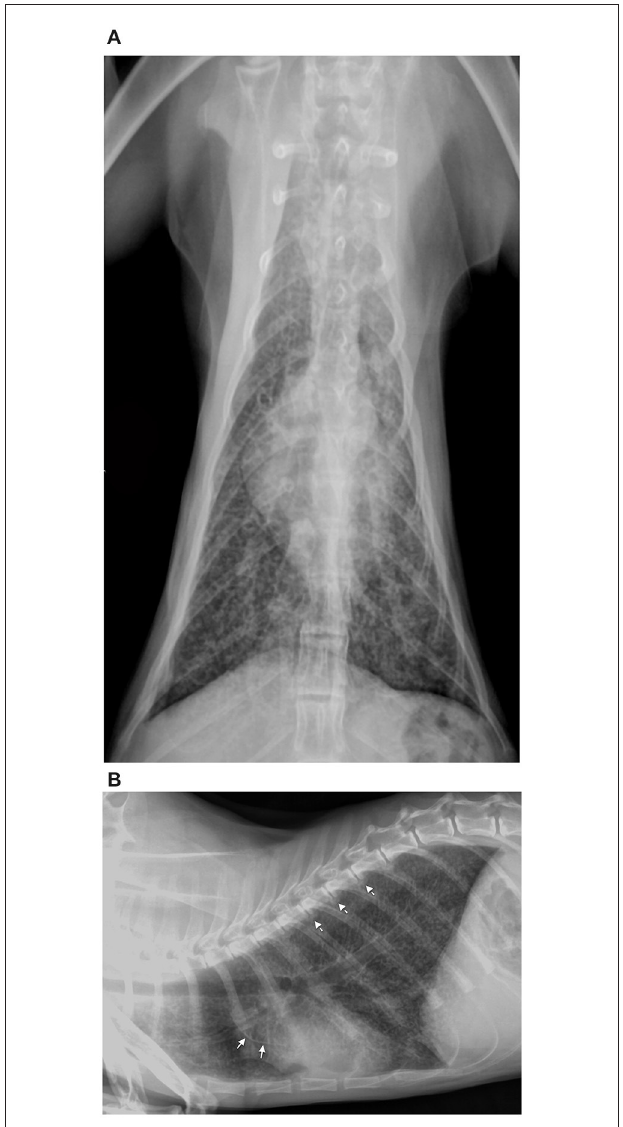
FIGURE 1 | Ventrodorsal (A) and right lateral view (B) thoracic radiographs of hypercalcemic case 2 revealed increased lung volume and a diffuse bronchointerstitial pattern with structured peri-bronchial mineralization. Furthermore, multiple areas of mineralization were visible along the aortic arch (arrow) and the ventral surface of the thoracic vertebral bodies (dotted arrow).